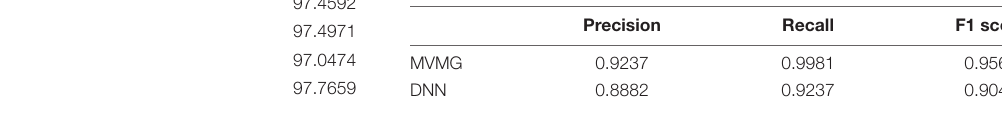
TABLE 4 | Classification report of the highest accuracy test